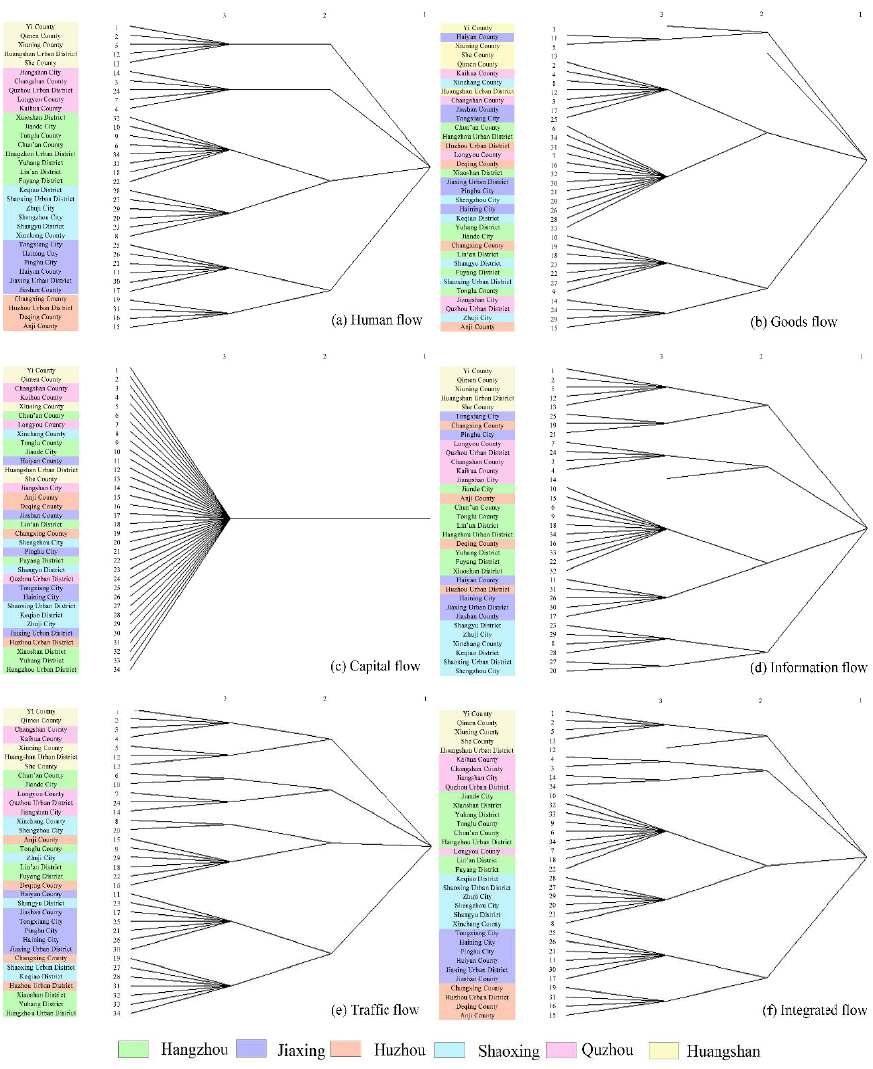
Figure 7. The division diagram of cohesive subgroups.